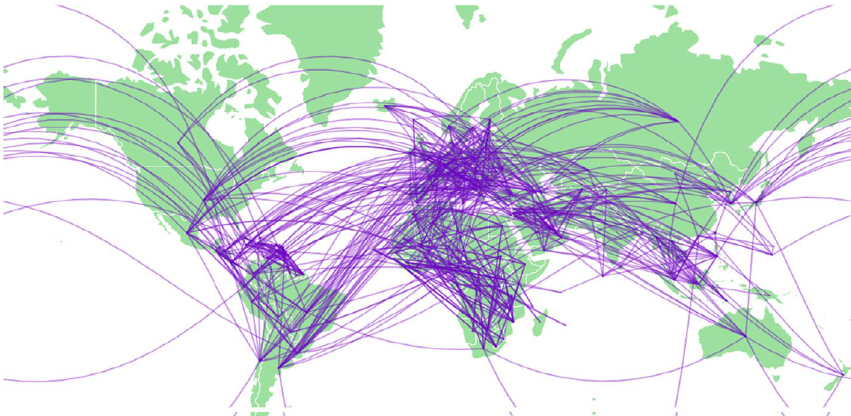
Fig. 1 Football network in 2014. The arcs (graph edges) connecting two countries (graph nodes) represent the football games played